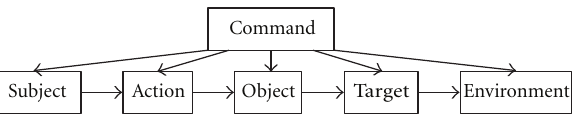
Figure 3: Command